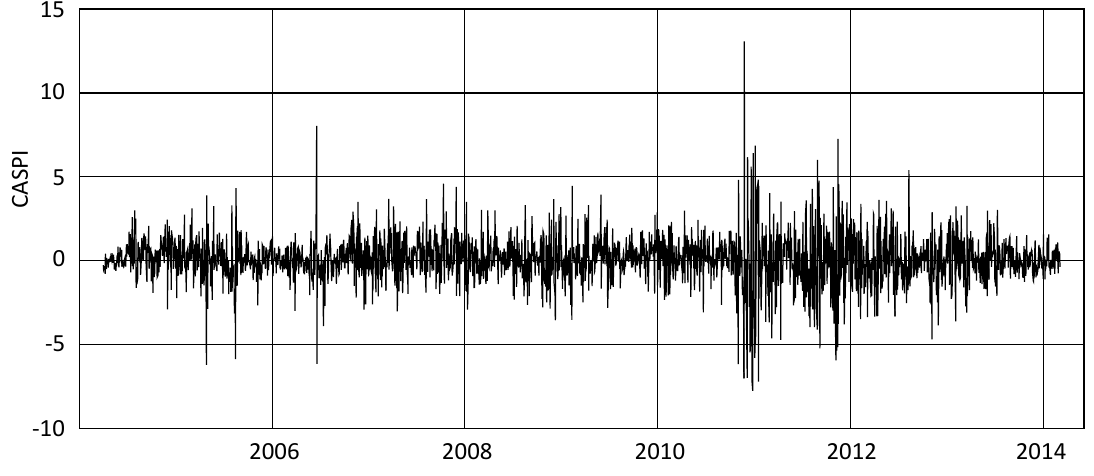
Figure 2. Frequent volatilities with extensive amplitude at DSE